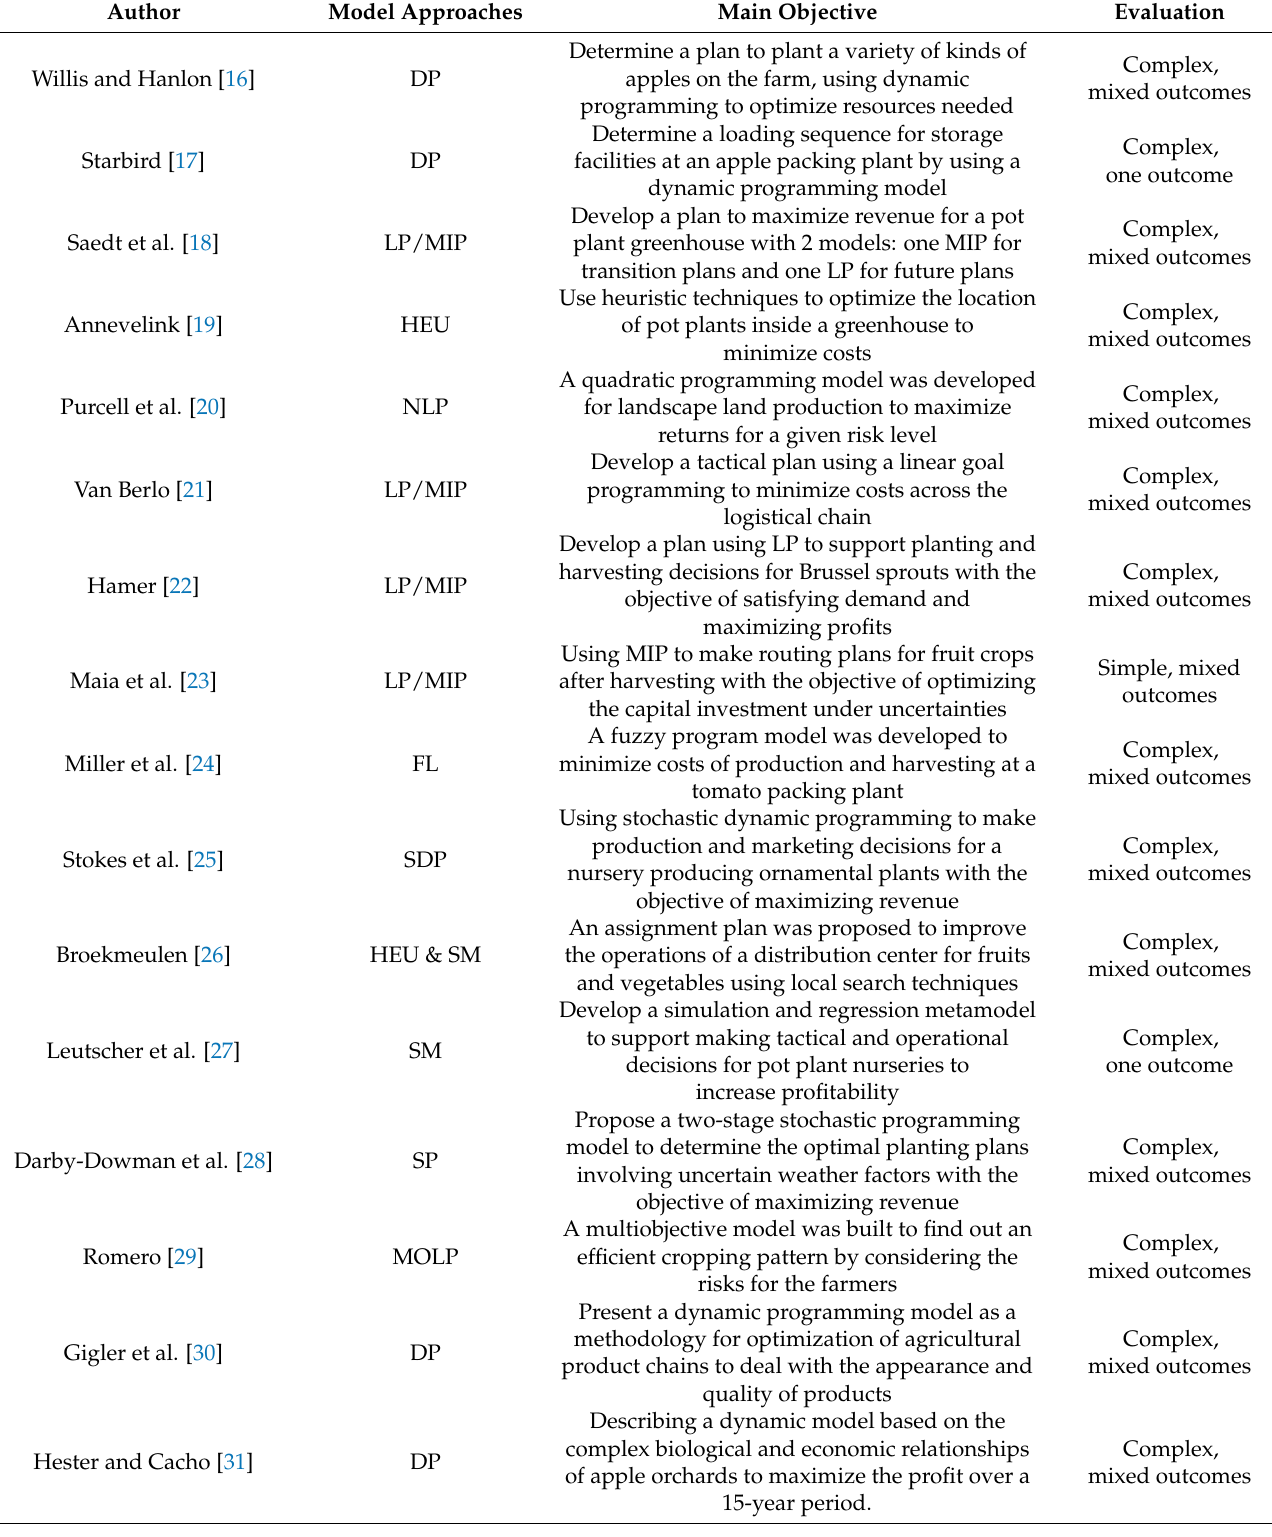
Table 2. Summary of mathematical models in references dealing with fresh fruit supply